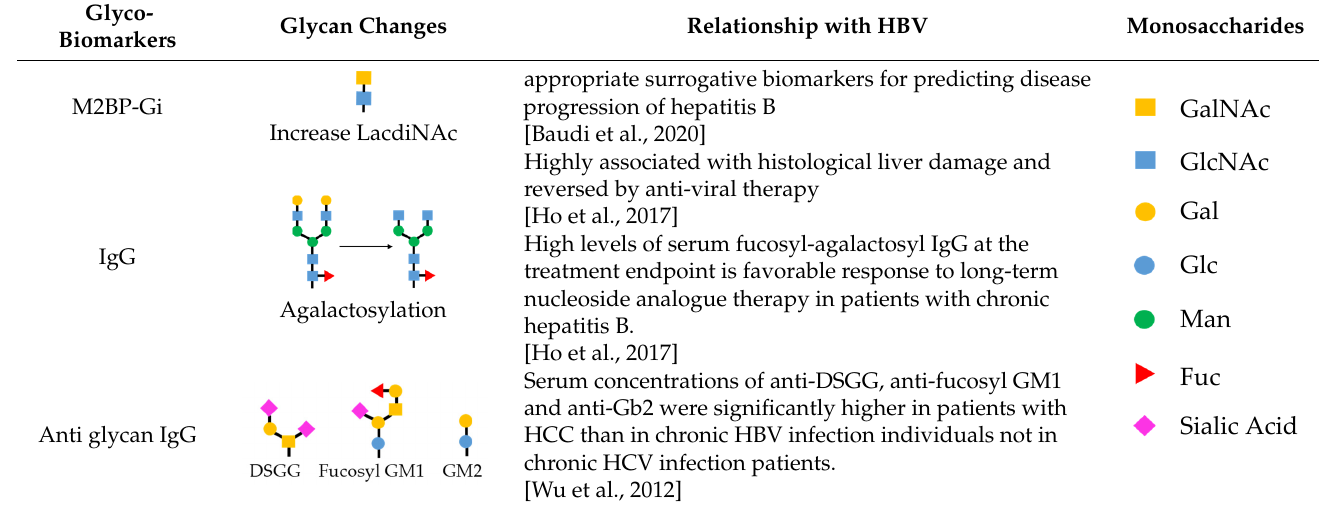
Table 1. Glyco-biomarkers for hepatitis B-related liver diseases. M2BP-Gi is Mac-2 binding protein glycosylation isomer recognized by WFA lectin. WFA binds to LacdiNAc structures (GalNAc-GlcNAc). IgG, immunoglobulin G. DSGG, fucosyl GM1, and Gb2, glycolipids. Yellow square, GalNAc; blue square, GlcNAc; yellow circle, galactose; blue circle, glucose; green circle, mannose; red triangle, fucose; pink diamond, sialic acid.